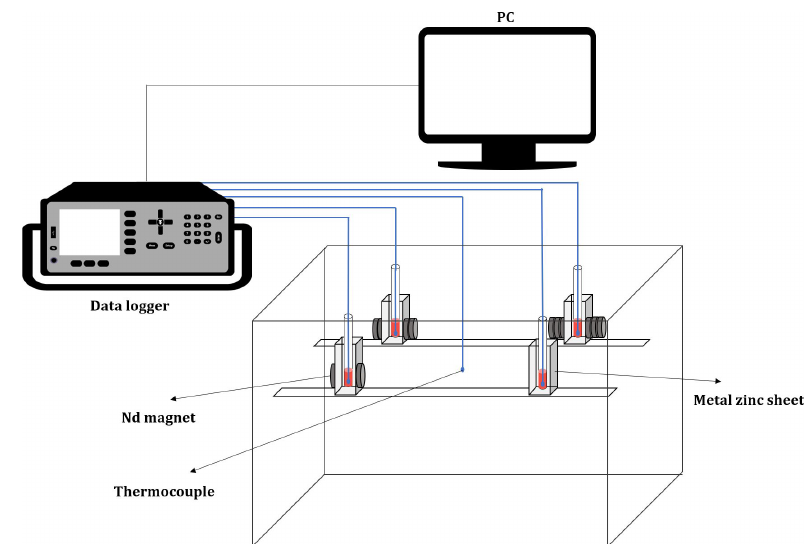
Figure 1. Schematic experiment for freezing of CoNHH in magnetic